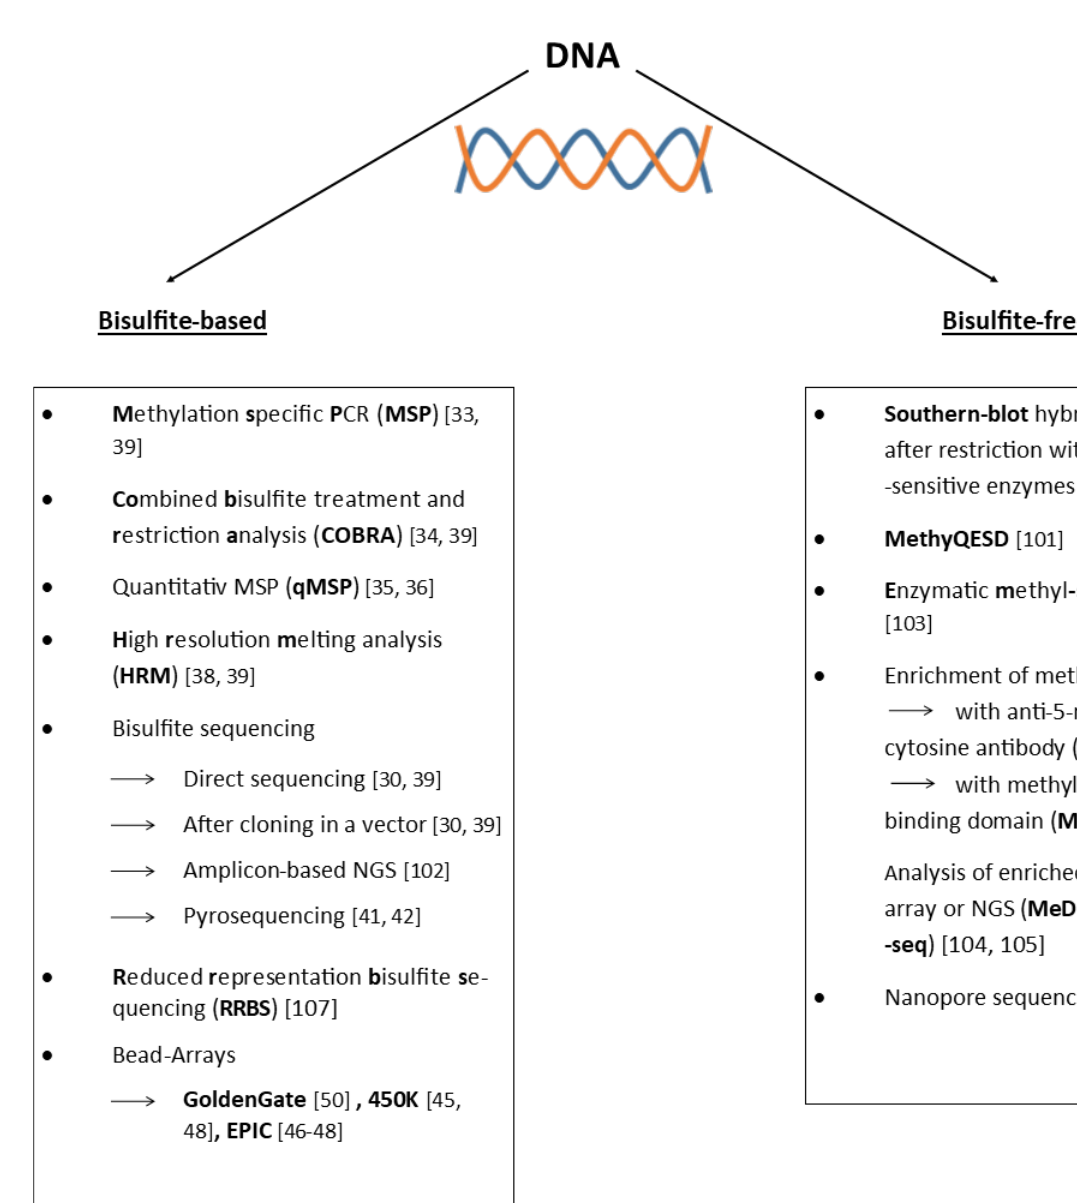
Figure 1. Conceptual overview of the most frequently used techniques used for studying DNA methylation [30,33 – 36,38,39,41,42,45 – 48,52,54 – 61]. More in-depth information about the methodologies and useful further references can be found in refs. [30,62].